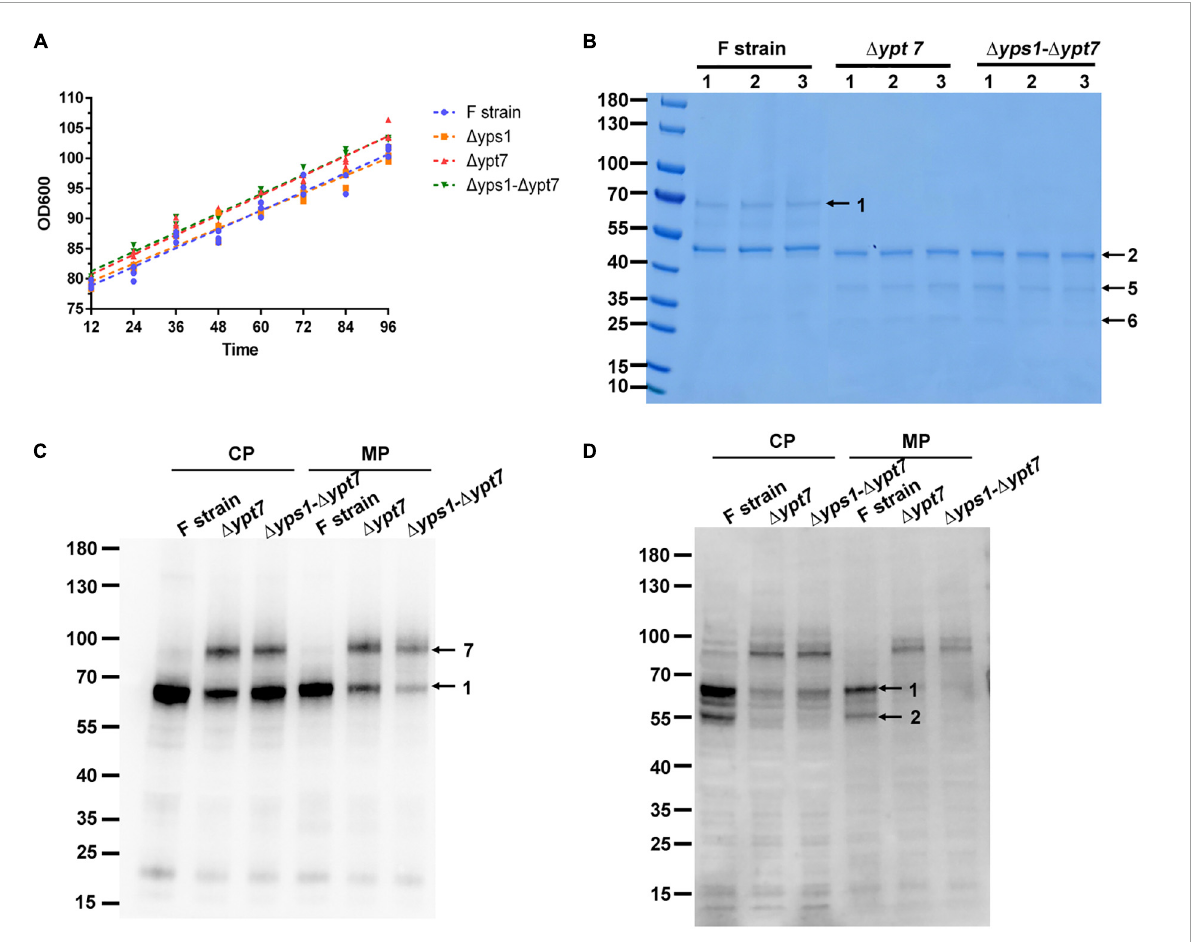
FIGURE6 Cell growth and HSA-pFSH β production in (cid:49) ypt7 and (cid:49) yps1 - (cid:49) ypt7 strains. (A) The cell growth curve (OD 600 ) of (cid:49) yps1 and (cid:49) yps1 - (cid:49) ypt7 strains. The same amount of cells were inoculated into the induction medium. A linear regression of OD 600 values against time was performed. Results are means ± standard deviations ( n = 3). (B) Effect of YPT7 gene disruption on the yield of HSA-pFSH β in the culture medium of F, (cid:49) ypt7 , and (cid:49) yps1 - (cid:49) ypt7 strains. Arrow 1, HSA-pFSH β protein; arrow 2, HSA truncated fragment; arrows 5 and 6, degraded fragments of HSA-pFSH β . (C,D) Western blot analysis of HSA-pFSH β protein in cells of YPT7 gene disruption strains. Blots were probed with antibodies specific for mouse 6 × His tag monoclonal antibody (C) and human FSH β monoclonal antibody (D) . Arrow 7, not fully processed HSA-pFSH β containing the full-length α -factor signal peptide sequence. CP, cytosolic protein; MP, membrane-associated protein.